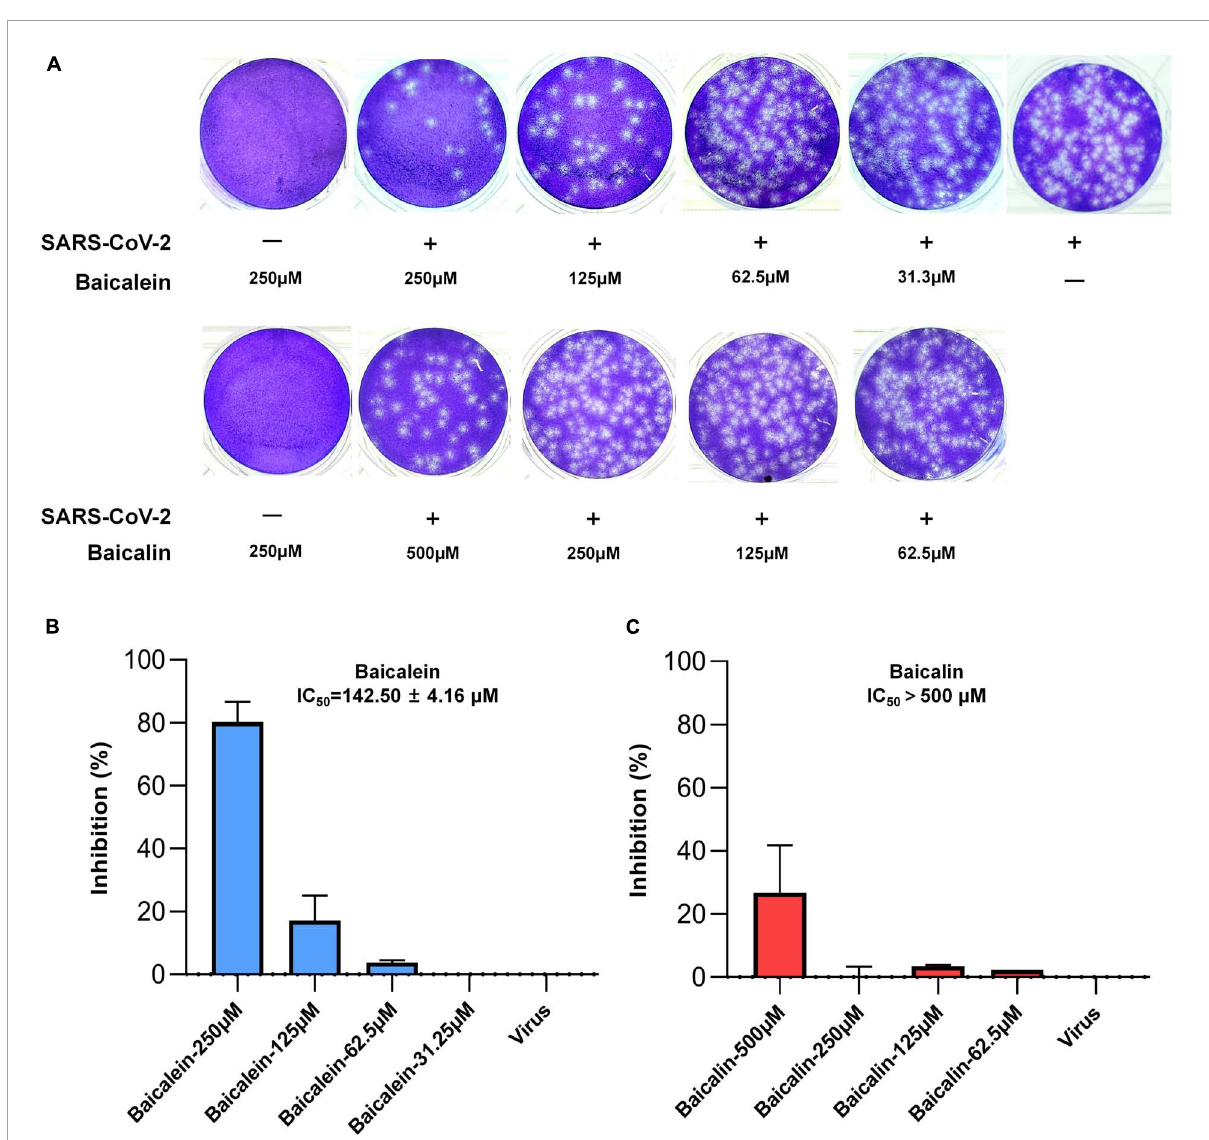
FIGURE9 The antiviral effects of baicalein and baicalin against SARS-CoV-2 virus by plaque reduction assay. (A) The photographs of plaque reduction assay treated with different concentrations of compounds. Inhibitory activities of (B) baicalein and (C) baicalin against SARS-CoV-2.